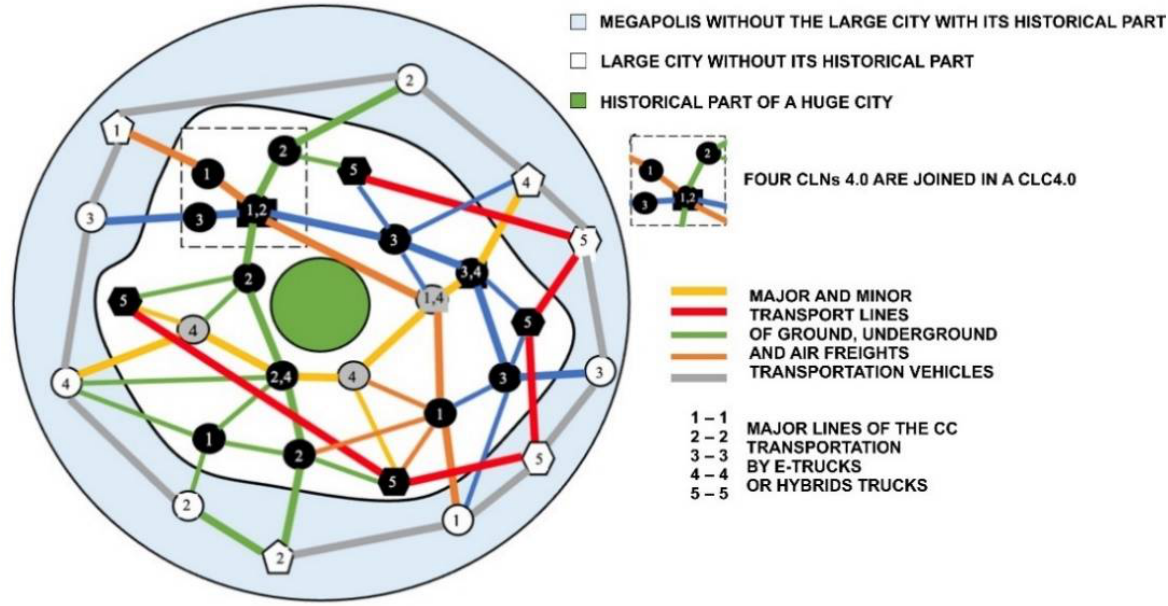
Figure 2. CLNs4.0 within a megapolis freight logistics networks for ground, underground, or air transportation vehicles: freight flows between CLNs4.0, CLNs4.0 of ATEPs, CWTSs, MLNs4.0, MTLHs4.0, MDLHs4.0, and MWTSs.